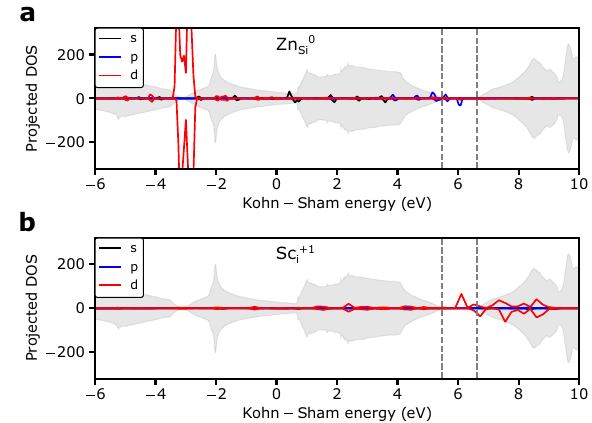
Fig. 7 Projected density of state (PDOS) for transitional metal atoms. PDOS for transition metals in representative ( a ) substitu- tional and ( b ) interstitial candidate defect systems are compared with density of state of bulk Si (shown by semi-transparent fi lled curve). The magnitude of PDOS is ampli fi ed 40 times in order to emphasize the location. Gray vertical dashed lines highlight the position of valence band maximum and conduction band minimum after potential